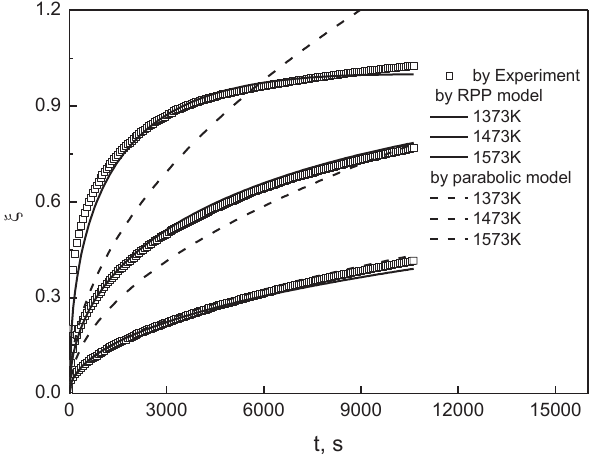
Figure 1. Comparisons between experiment data and model calculated data for oxidation of Si 3 N 4